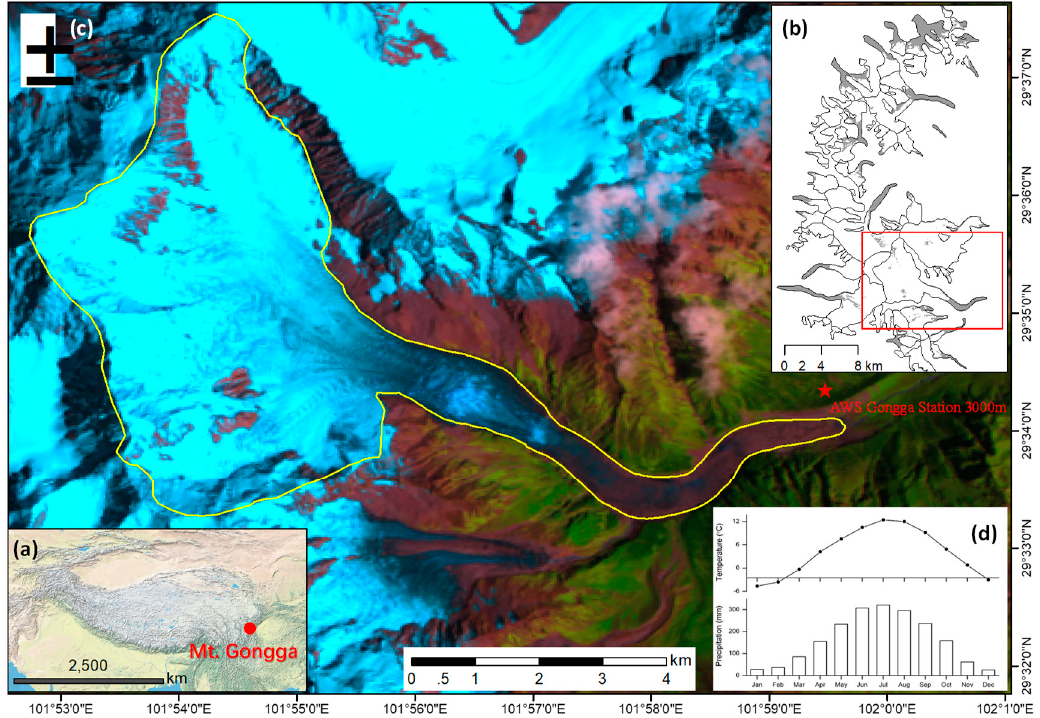
Figure 1. The location of Mount Gongga ( a ) and the glacier distribution ( b ) on the Southeastern Tibetan Plateau. The main panel shows the Hailuogou glacier in a Landsat 5 TM image (combination of bands) acquired on 05 September 1994. The yellow line indicates the glacier extent of Hailuogou glacier in 1994, while the red star represents Mount Gongga Station ( c ), where the meteorological observations ( d ) have been recorded since 1987.